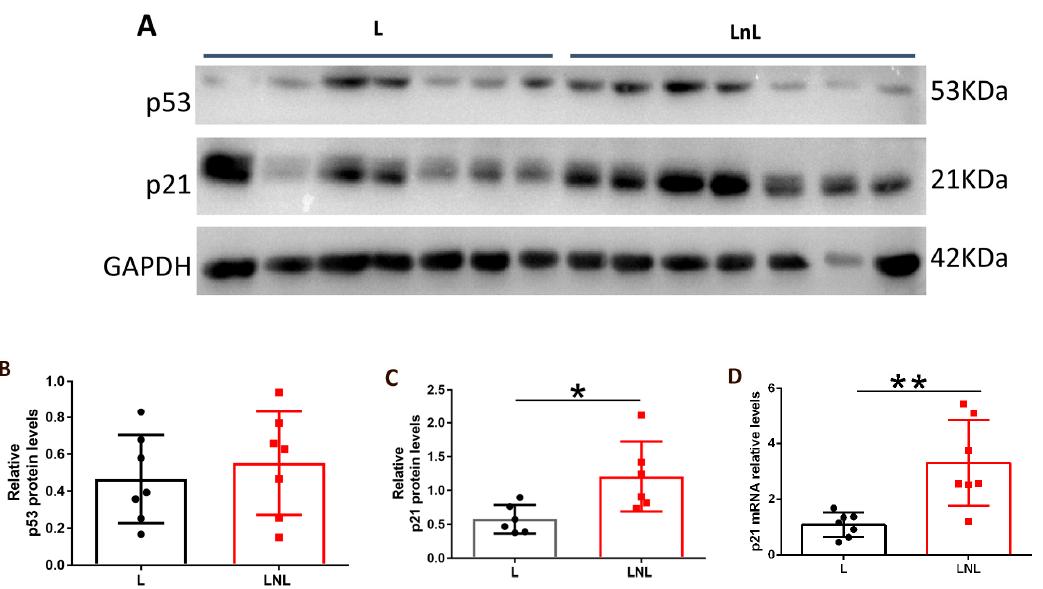
Figure 5. P53 activity is increased in LnL group. ( A ) WB analysis of indicated protein levels in muscles derived from animals of L and LnL groups, GAPDH was used as loading control. ( B ) Densitometric analysis of p53 relative to GAPDH levels (mean ± SD) in indicated groups (n.s., two-tailed unpaired t -test, n = 7/group). ( C ) Densitometric analysis of p21 relative to GAPDH levels (mean ± SD) in indicated groups (* p < 0.05, two-tailed unpaired t -test, n = 7/group). ( D ) RT-PCR analysis of p21 mRNA levels in indicated groups (** p < 0.01, two-tailed unpaired t -test, n =